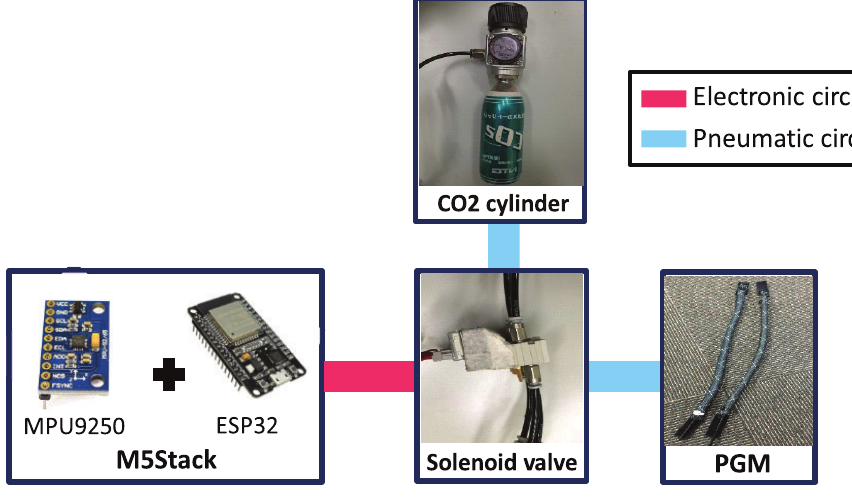
Figure 4. Details of the PGM